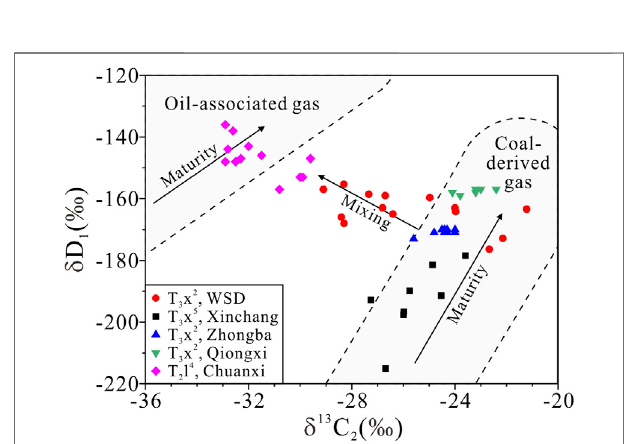
FIGURE 5 | The diagrams of δ 13 C 2 versus δ 13 C 1 (A) and δ 13 C 3 versus δ 13 C 2 (B) . The trends representing gases from Type III kerogen in Niger Delta and Type II kerogen in Delaware/ValVerde Basin (A) are after Rooney et al.(1995), and the trend for gasfrom Type III kerogen inSacramento Basin (A) are after Jenden and Kaplan (1989). The ranges for coal-derived and oil-associated gases (B) are from Dai (1999).